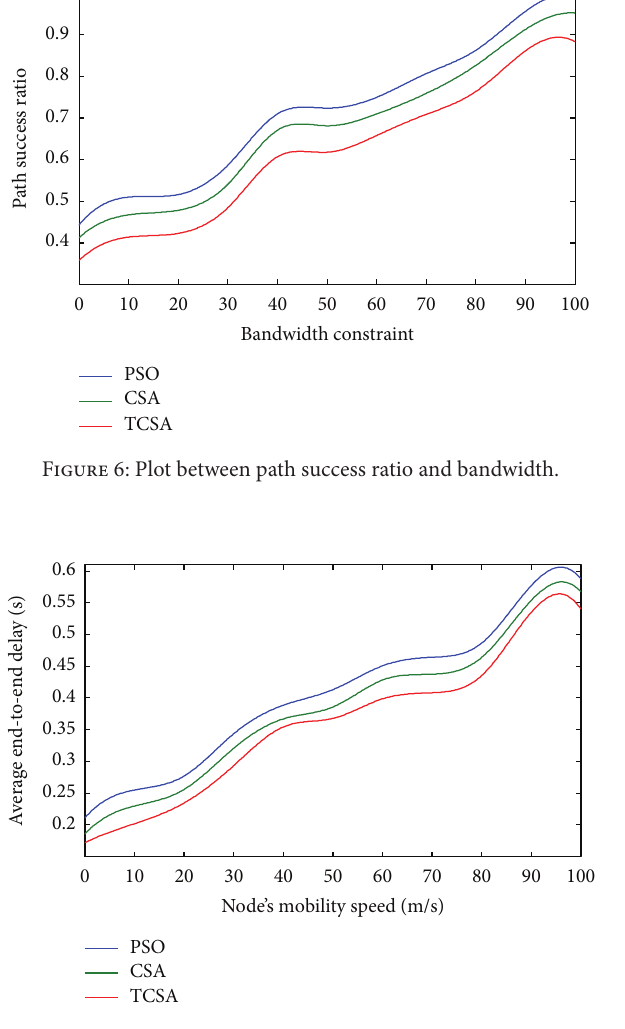
Figure 7: Plot between average end-to-end delay and node’s mobility